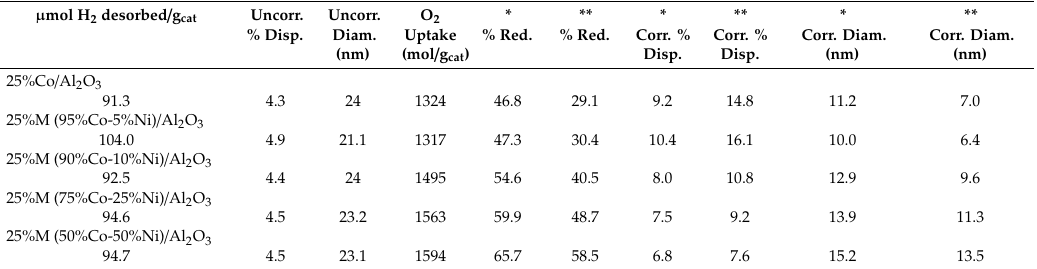
Table 2. H 2 chemisorption and pulse O 2